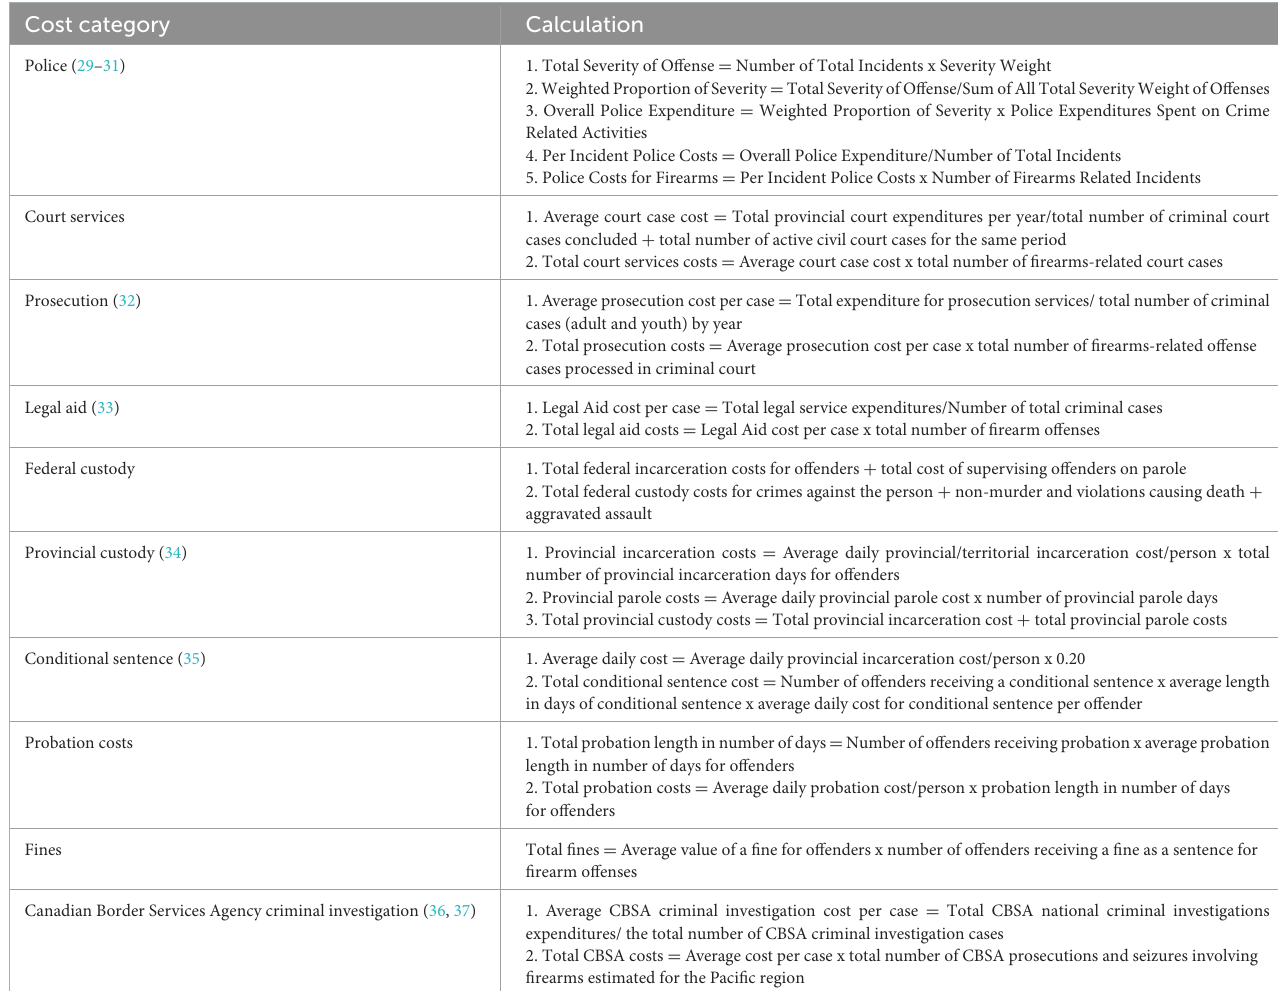
TABLE 2 Data calculations for criminal justice system costs. Cost